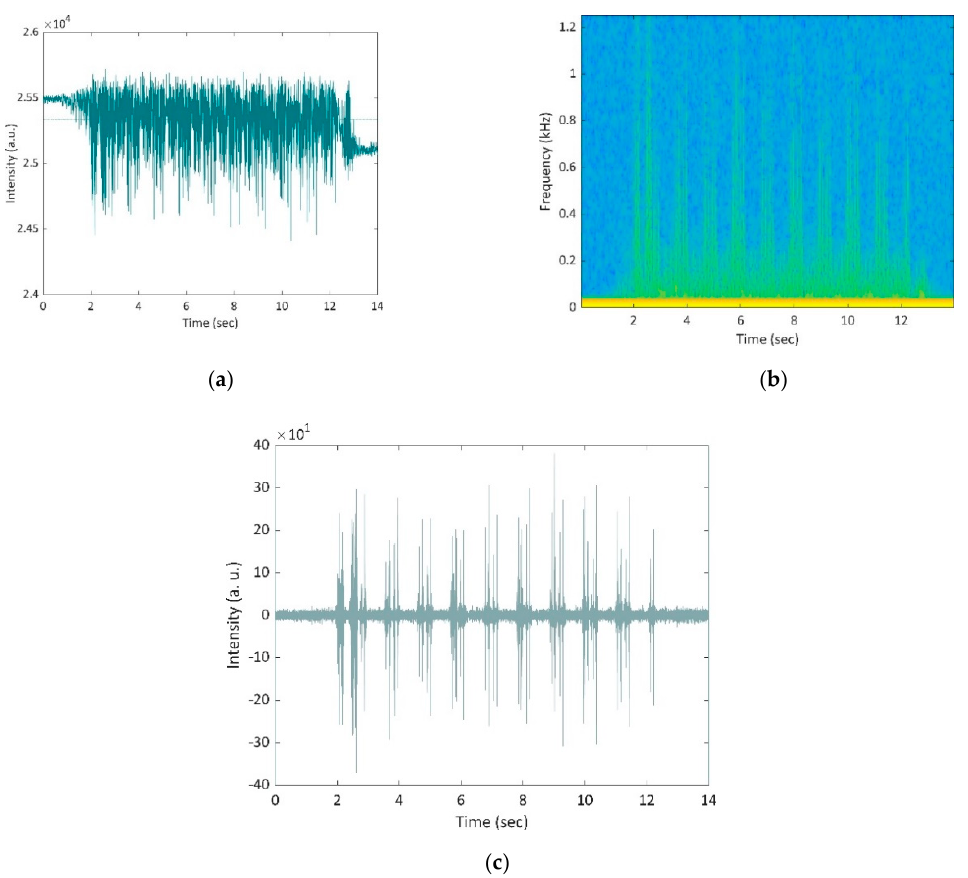
Figure 7. Raw backscattered signal ( a ), spectrogram ( b ) and filtered signal ( c ) of a train passing a rail joint in an advanced state of wear.